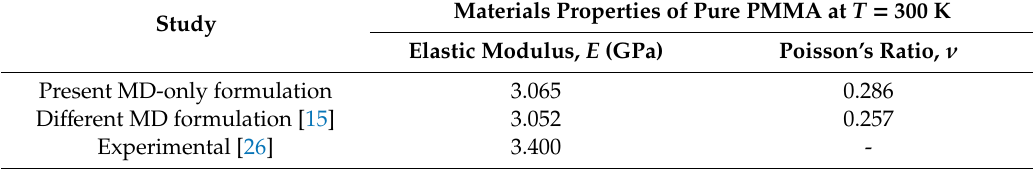
Table 2. Comparison of the elastic properties of the pure PMMA computed here via MD, with corresponding results from other